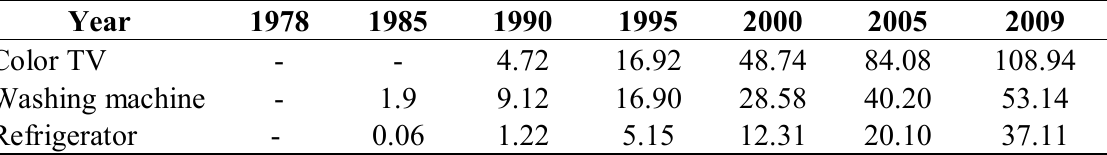
Table 5. Durable goods per 100 families for rural residents in